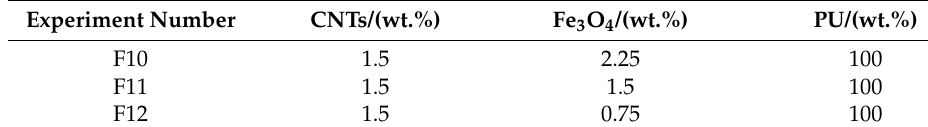
Table 4. Experimental scheme for the ratio of Fe 3 O 4 /CNTs.